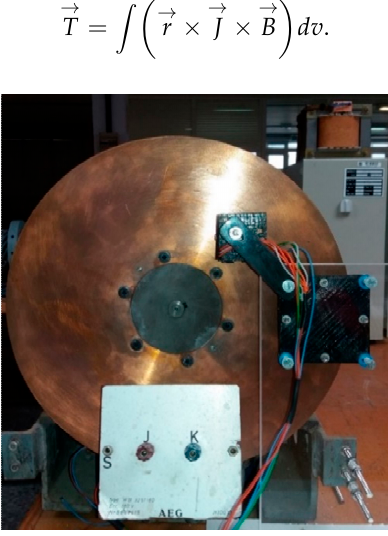
Figure 2. Disk, magnet and Hall sensors, frontal view.